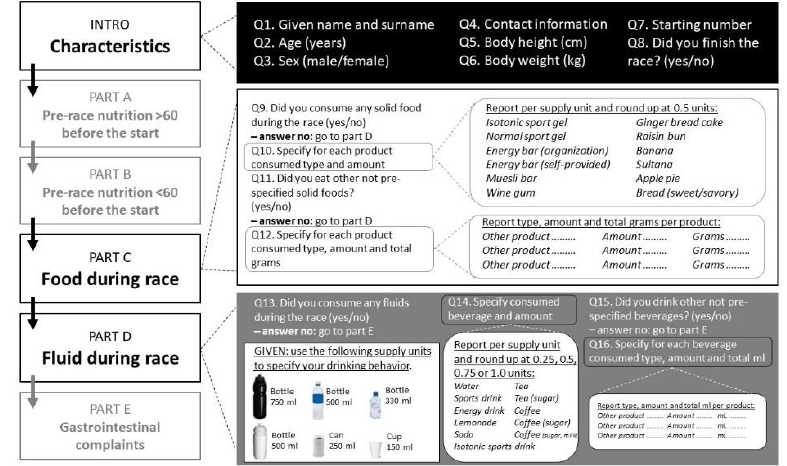
Figure 1. Overview of the food and fluid exercise questionnaire (FFEQ). For the purpose of this study, only responses to the INTRO, part C, and part D were used and validated against observations.